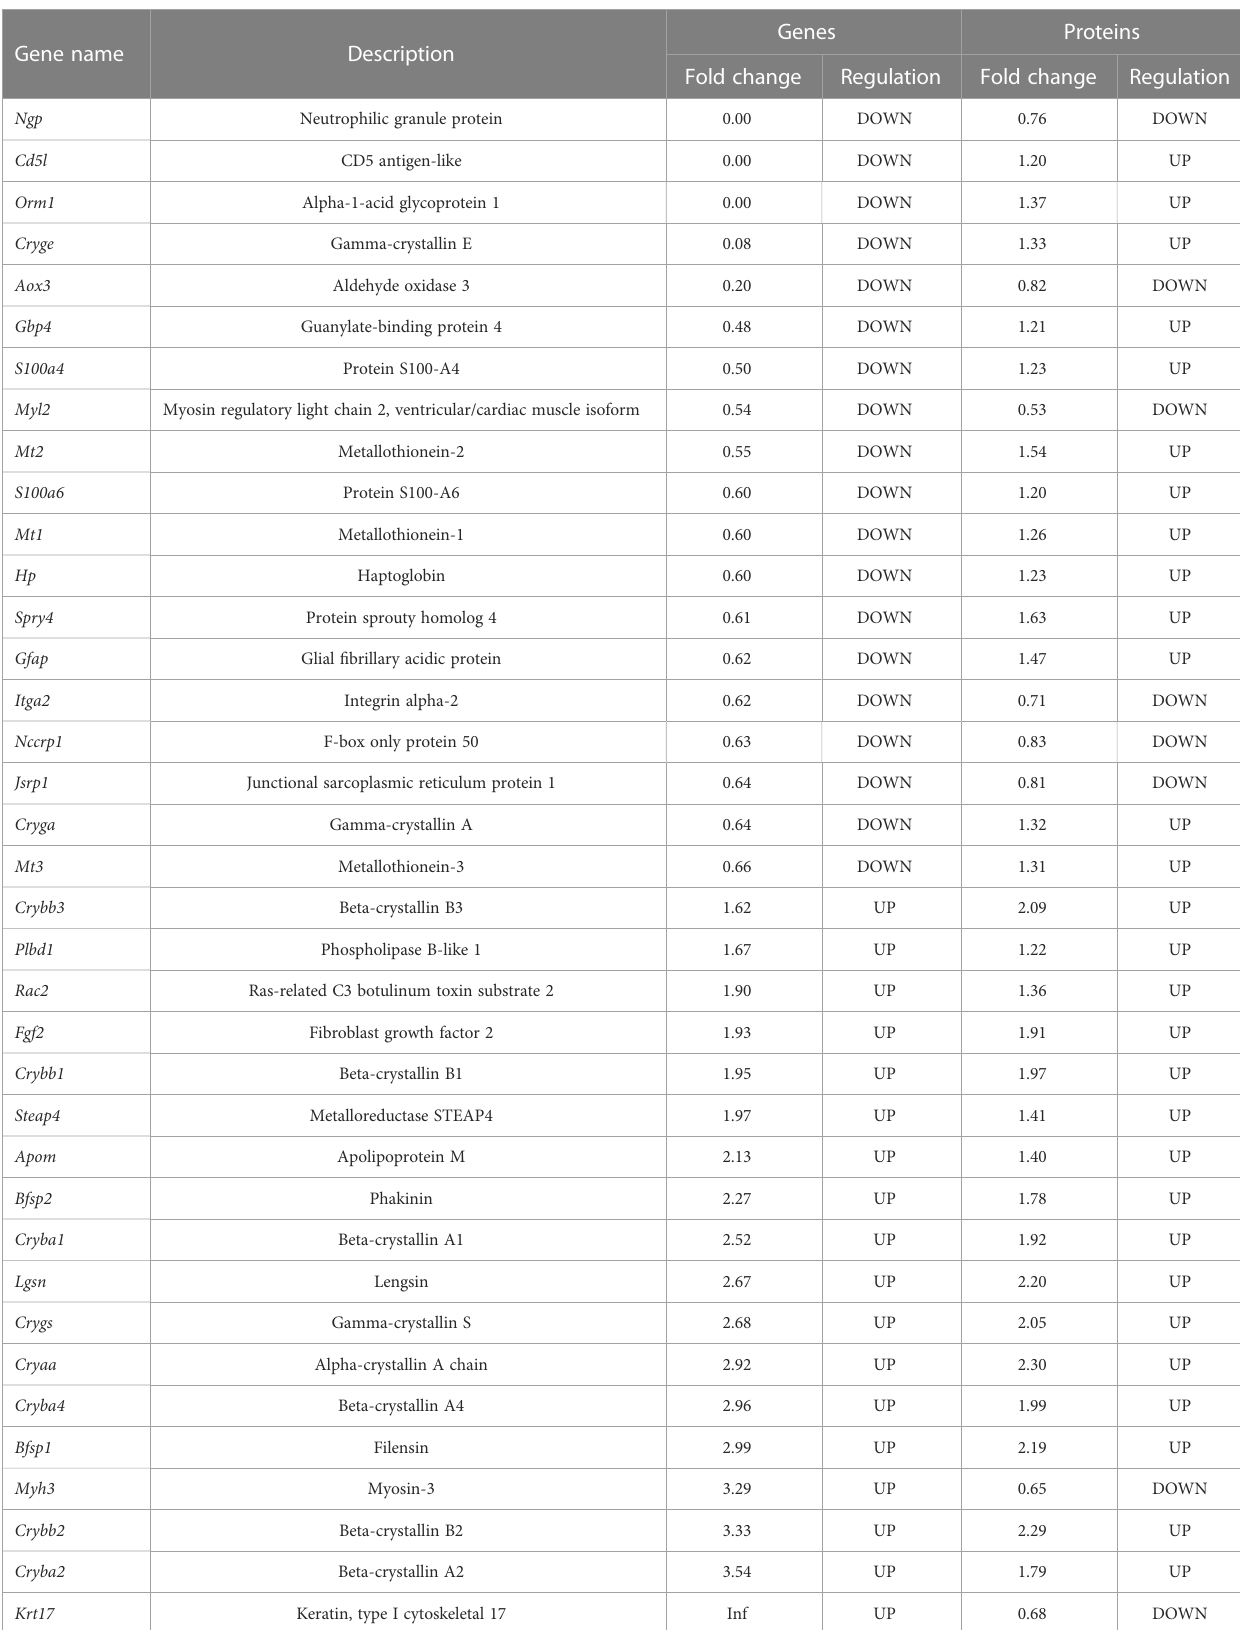
TABLE 1 Characteristics of the 39 overlapping targets in identi fi ed genes and